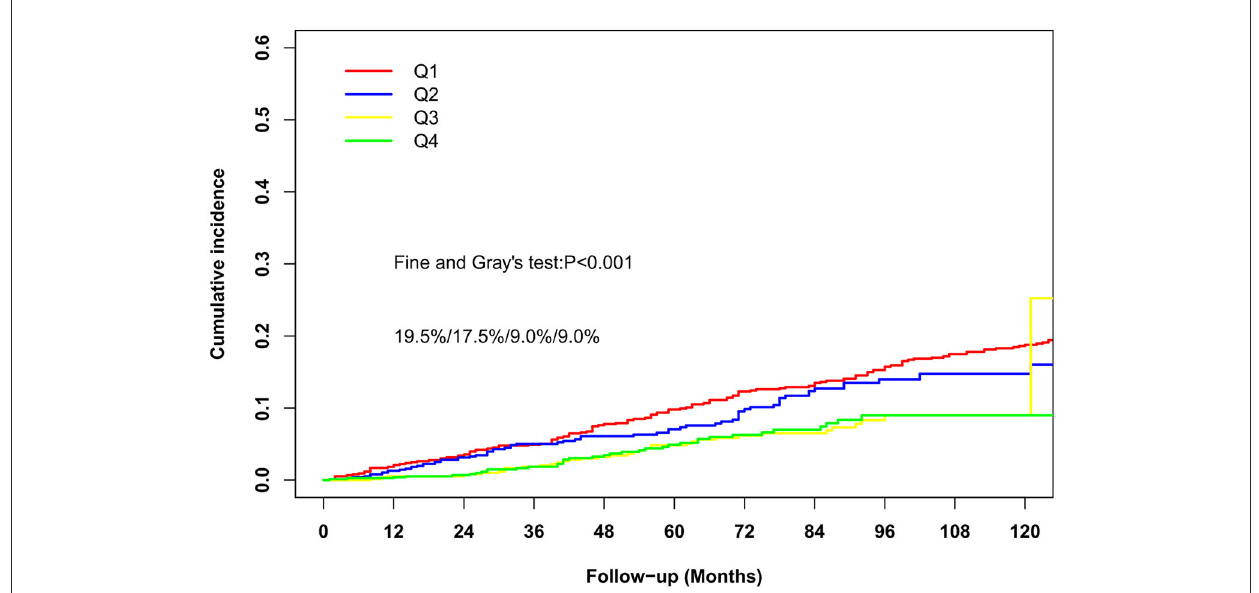
FIGURE3 The cumulative incidence of cardiovascular-cause death in the four study groups during the follow-up period.